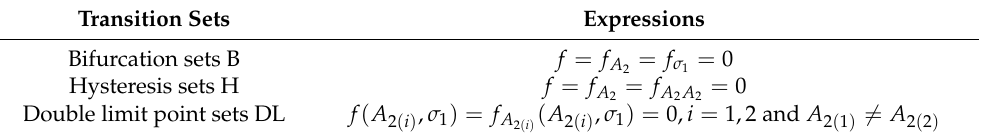
Table 1. Expressions of the transition sets of the singularity